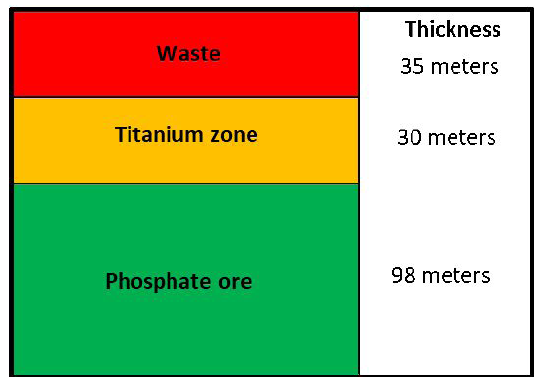
Figure 4b show EDS spectrum of the elements identified